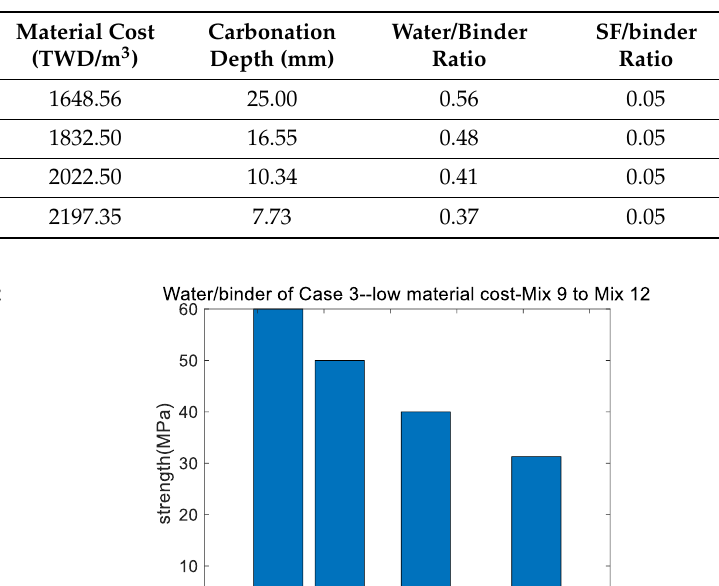
Table 11. Performance of optimal design mixtures for Case 3: low-material-cost concrete with carbonation.